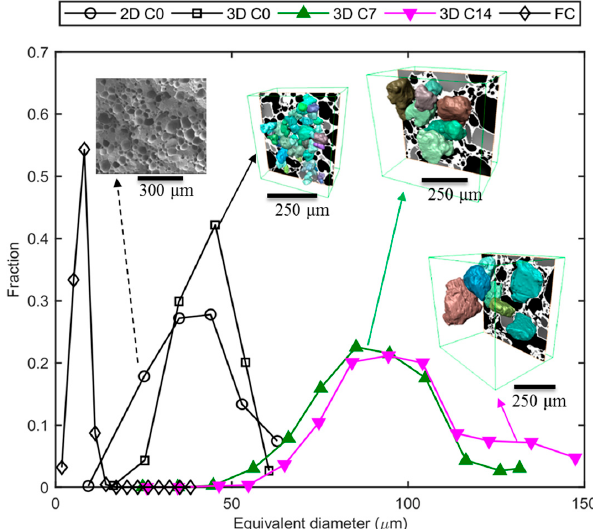
Figure 8. The size distributions of ice crystals in the ice cream samples following the FC stage from the in situ experiment, and C0, C7, C14 samples from the ex situ experiment. For the ex situ experiments, the morphology of the ice crystals is shown in the inserts as 3D color renderings of individual ice crystals. Additional data are taken from Reference [7].